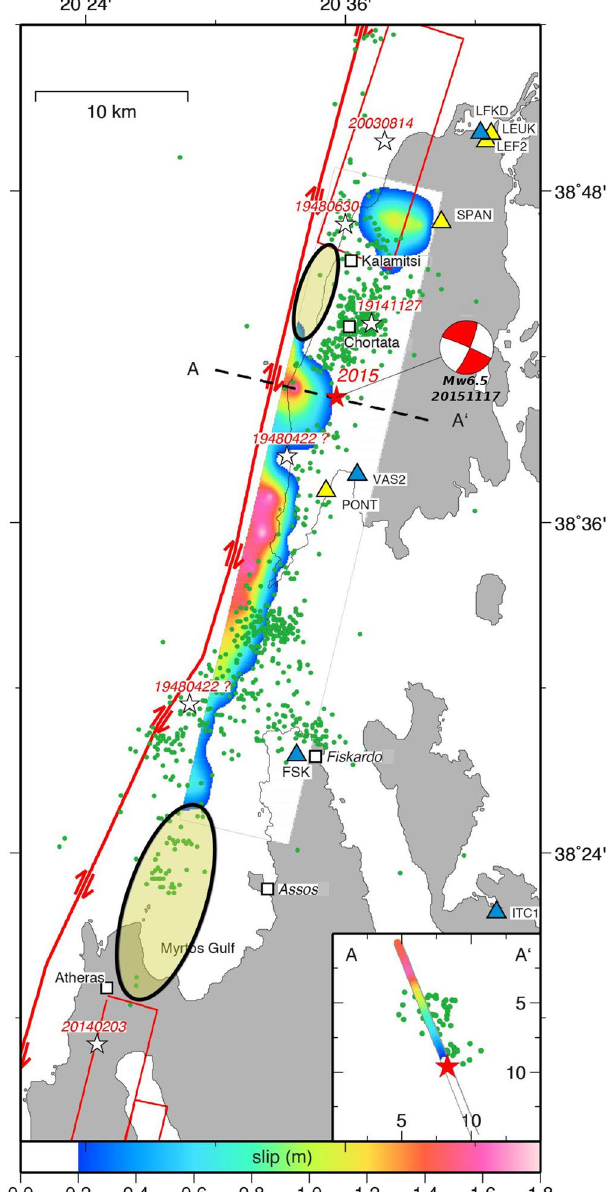
Figure 5. Seismo-tectonic map with inverted rupture model. Inverted rupture model (Fig. 3a) projected on the Earth surface. Colours on the fault plane indicate the slip distribution. The red star and the beach ball show the location of the main shock 2 and the USGS focal mechanism 3 . The green dots represent the 956 relocated aftershocks in the time period 2015/11/17-2015/12/30 2 . The red fault boxes shown to the NE and to the SW of the 2015 Lefkada causative fault (this study) represent the locations proposed for the faults related to the previous Lefkada August 14, 2003 24 and the Cephalonia January 26 th and February 3, 2014 25, 26 earthquake sequences, respectively. The inset shows the estimated slip distribution as function of depth (symbols as in the main figure). The black yellow-shaded ellipses correspond to slip deficit areas as suggested in this study. Map was created using the GMT (Generic Mapping Tools, http://gmt.soest.hawaii.edu/) software package 57 , version